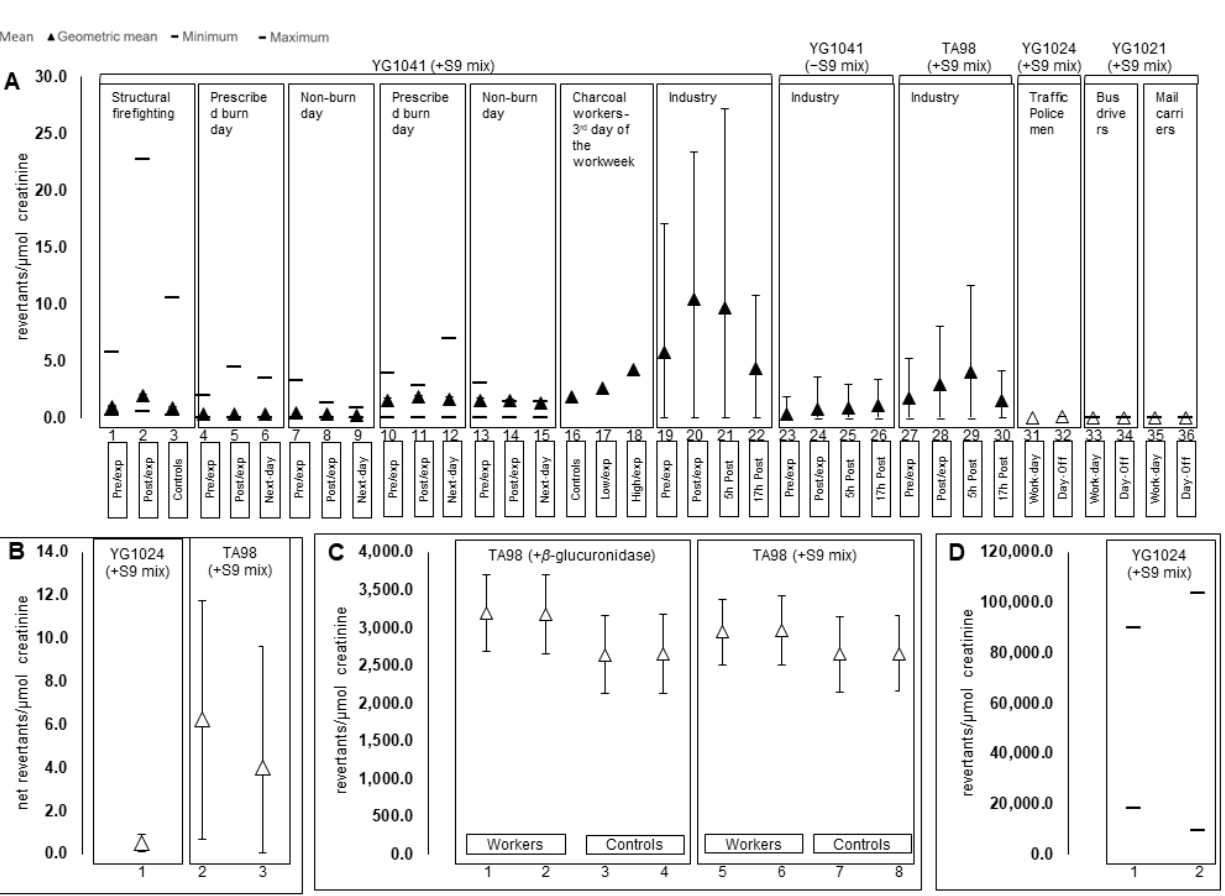
Figure 2. Graphical representations of urinary mutagenicity of the studies that report creatinine adjusted levels as revertants/µmol creatinine ( A , C , D ), or net revertants/µmol creatinine ( B ). ( B ): coke oven workers; ( C ) textile-industry workers; ( D ) rubber manufacture workers.